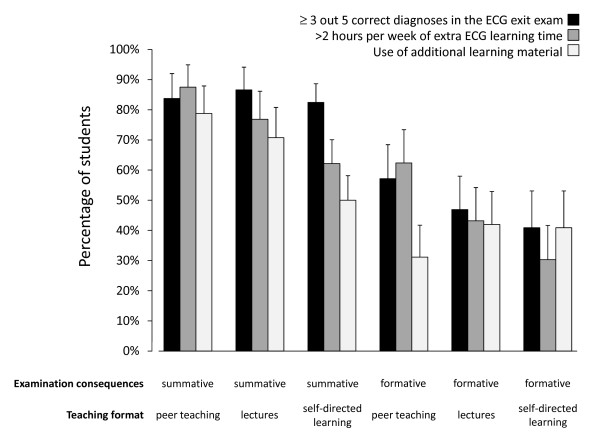
Descriptive analysis of primary and secondary outcomes. The figure shows percentages of students correctly identifying at least three out of five diagnoses in the electrocardiogram (ECG) exit examination (black columns), self-reporting to have spent more than 2 h/week on independent ECG self-study (dark gray columns) and of having used additional ECG learning material during the module (light gray columns) by study group. Error bars indicate 95% confidence intervals of prevalence estimates.